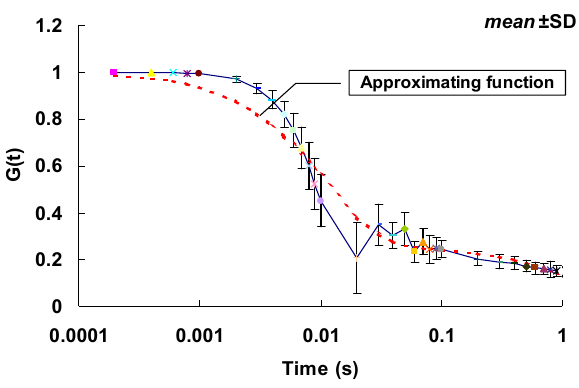
Fig. 6: Time courses of the relaxation response following stepwise stretch of brain